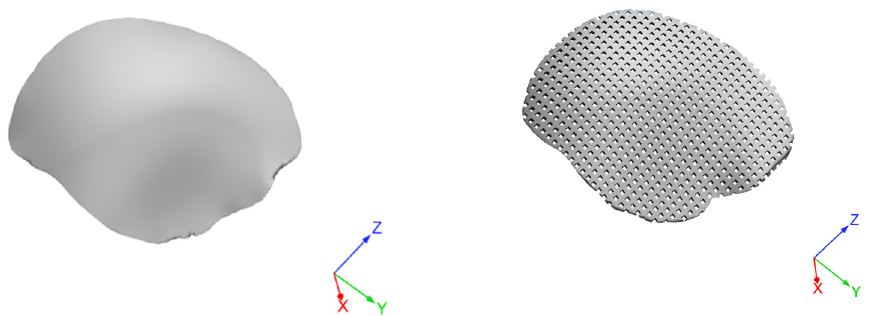
Figure 3. Three-dimensional geometrical models of a customized device for large cranial defect: non-porous model ( left ); model with interconnected pore network ( right ).